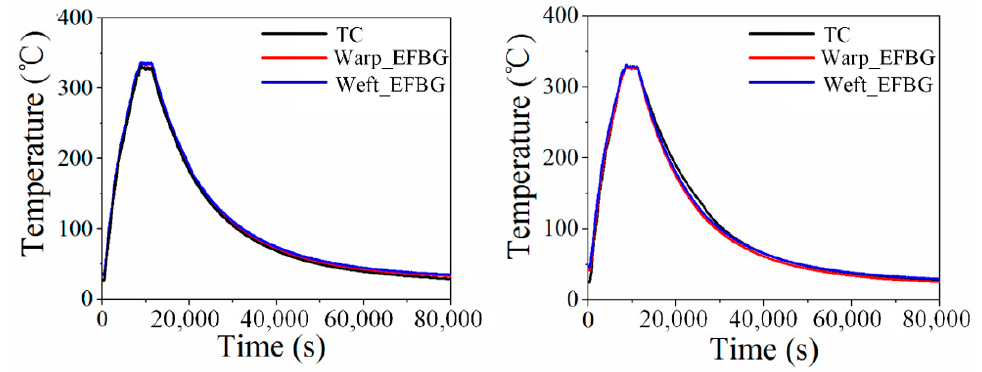
Figure 11. Temperature cycles of the other two repeated experiments.